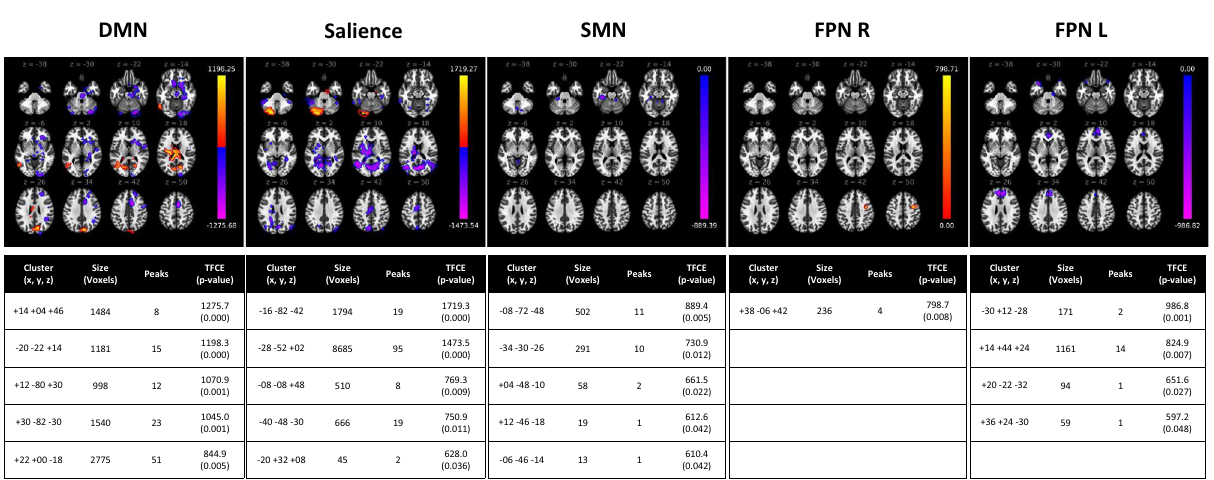
Figure 5. rs-fMRI differences between females with concussion and healthy females. Clusters (x, y, z) denote standard MNI coordinates at the center of cluster mass, and size represents number of voxels. Only one cluster survived analysis for the frontoparietal right; with multiple clusters identified for all other seeded